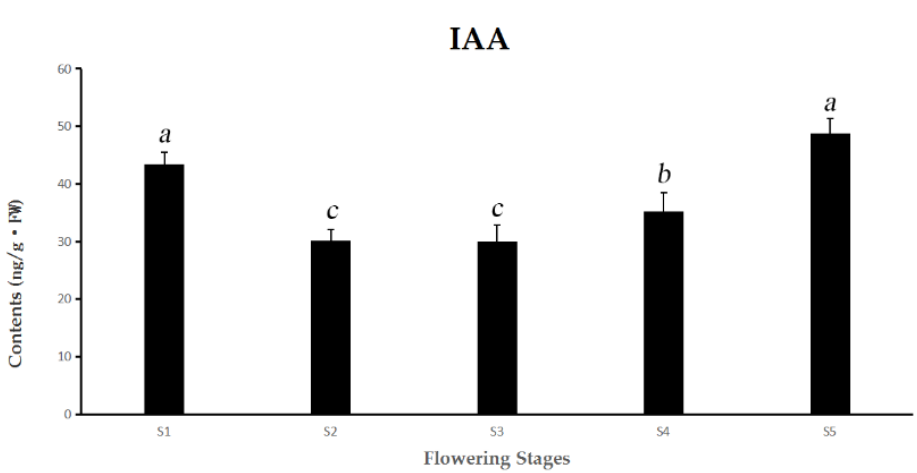
Figure 10. The indoleacetic acid (IAA) concentrations at different stages of Osmanthus S1 (linggeng stage), S2 (bud eye stage), S3 (initial flowering stage), S4 (full flowering stage), and S5 (late flowering stage). The error bars represent the standard error from three biological replications. Significant differences detected with Duncan’s multiple range test at p < 0.05 are indicated by different lowercase letters above the error bars.